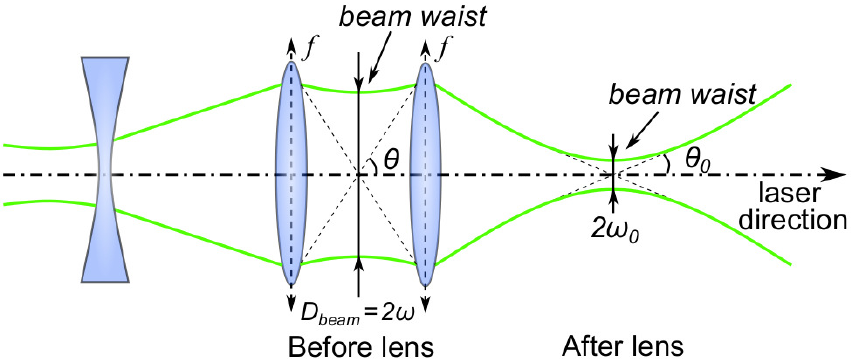
Figure 8. Schematic diagram of the laser path through the lens